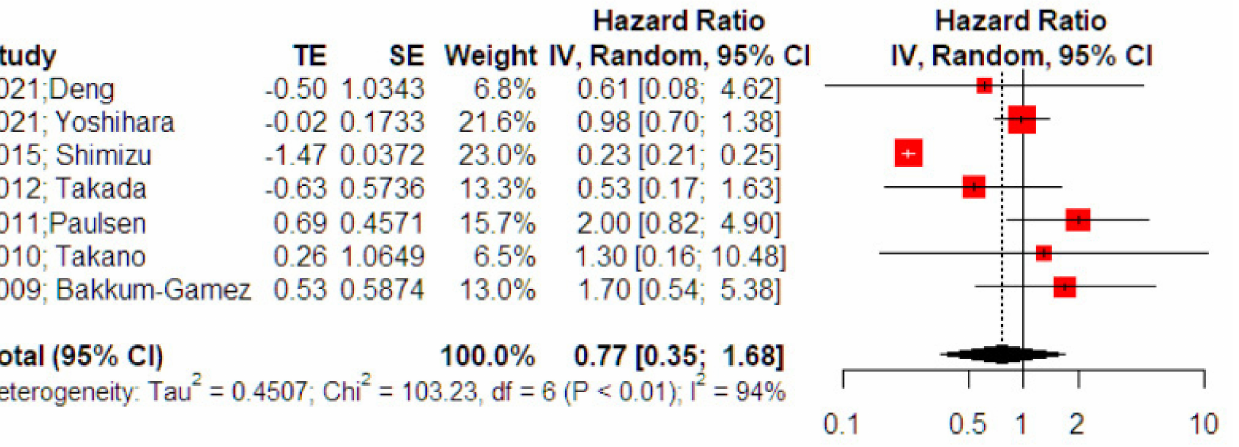
Figure 2. Forest plot of recurrence-free survival among patients with intraoperative cyst rupture that receive chemotherapy compared to those treated with expectant management (right side): Vertical line = “no difference” point between the two groups. Red squares = odds (hazard) ra- tios; diamond = pooled mean odds (hazard)radio and 95% CI for all studies; horizontal black lines = 95% CI